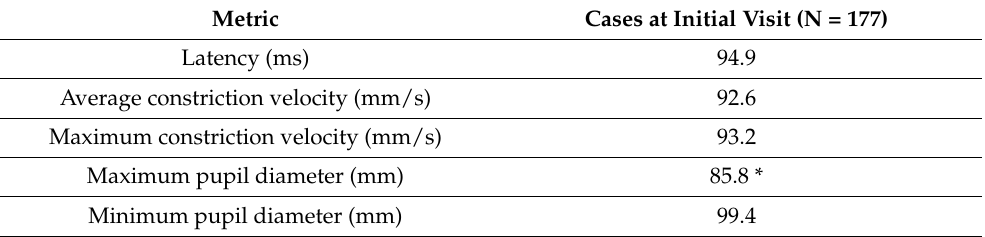
Table 2. Percentage within 2.5th and 97.5th percentile reference range comparison for human study cohort.